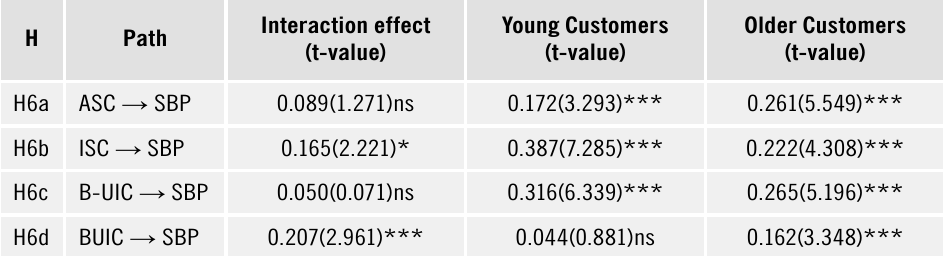
Table 4. Moderating effect of